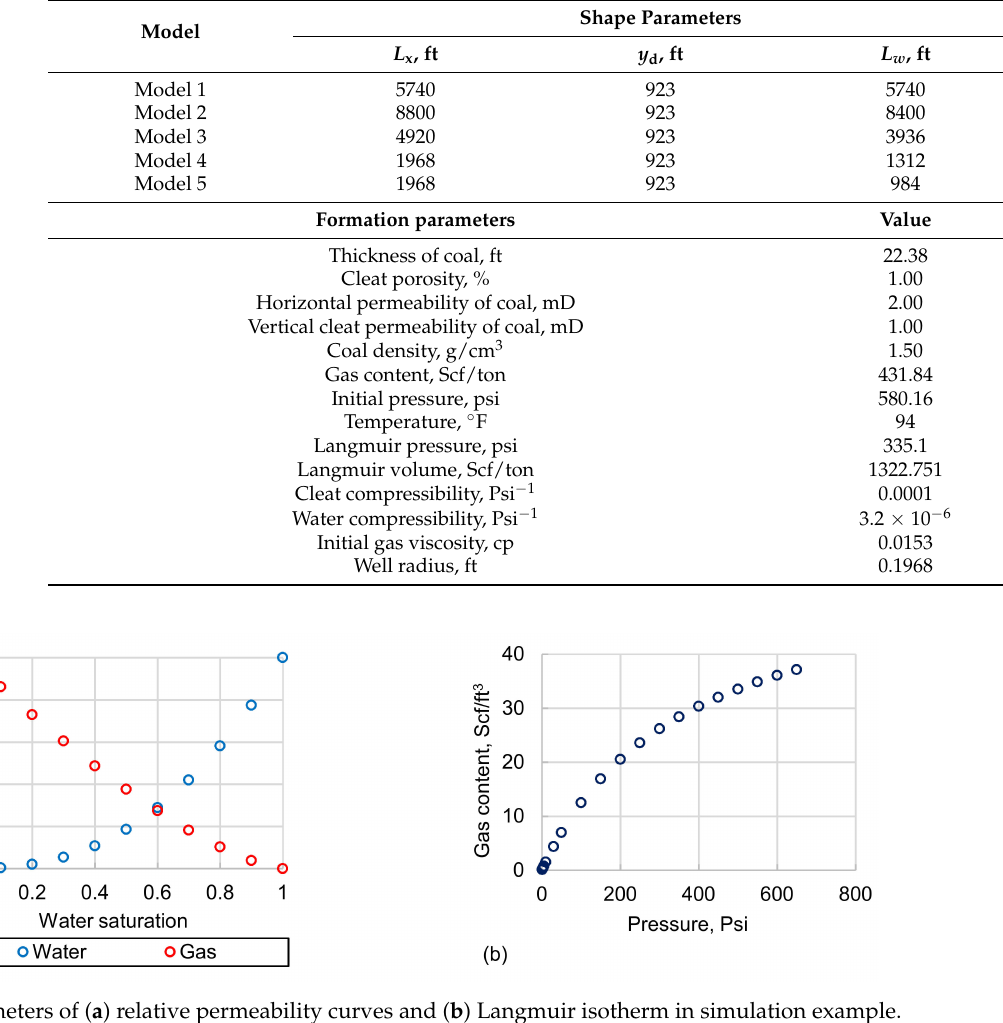
Figure 5. Parameters of ( a ) relative permeability curves and ( b ) Langmuir isotherm in simulation